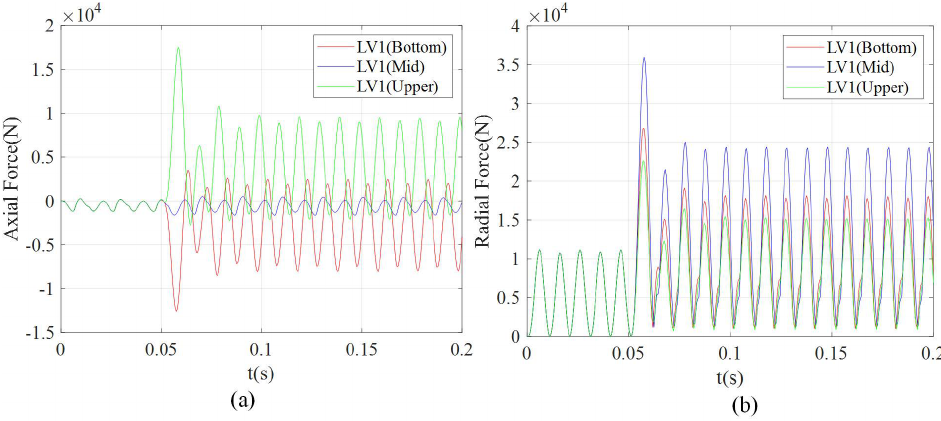
Figure 8. The radial resultant force and axial resultant force of LV1 under the TTFs at different positions. ( a ) The axial resultant force. ( b ) The radial resultant